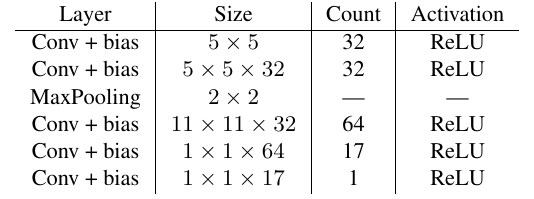
Figure 6. Examples of image sharpening by the grid warping algorithm with different